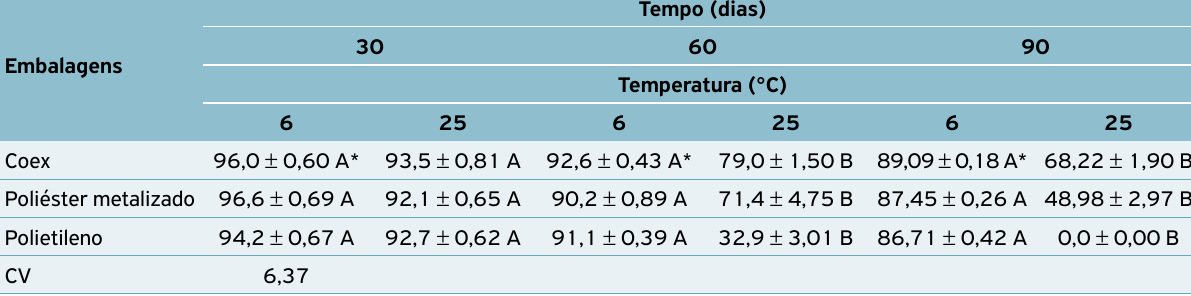
Tabela 2. Média e erro padrão da porcentagem de germinação de conídios de B. bassiana em mistura granulada acondicionada